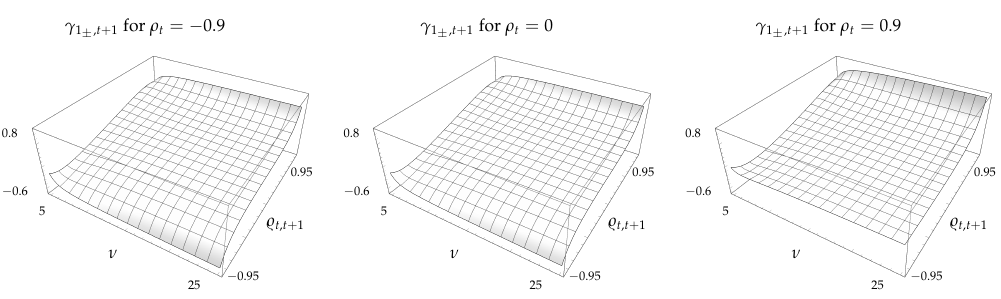
, of CSM return as a function of ν and (cid:36) t , t + 1 . ± , t + 1